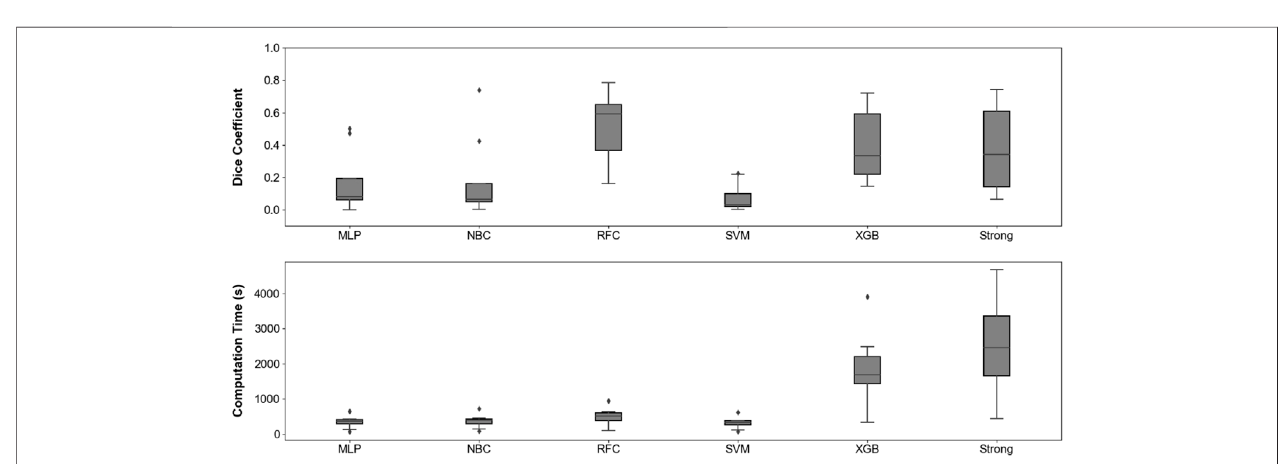
FIGURE 5 | Distribution of Dice coef fi cient (A) and computation time (B) when applying our annotation procedure to eight different medical examples images. Corresponding raw data is available in Supplementary Table S1 .